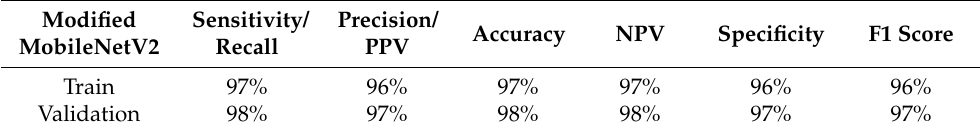
Table 9. Modified MobileNetV2 model performance on training and validation set.